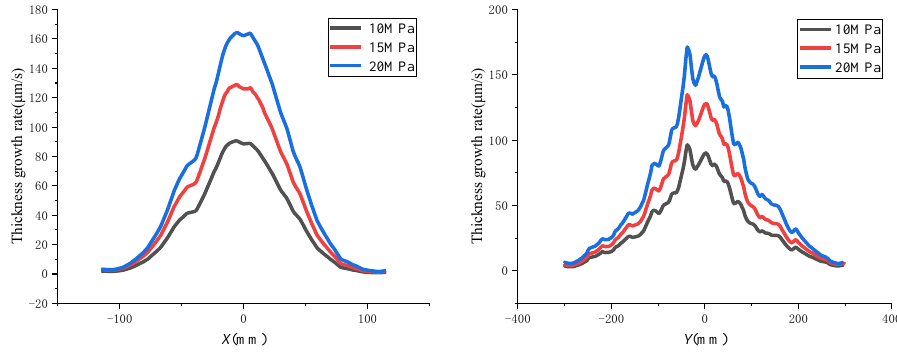
Figure 15. Growth rates of coating films under different spraying pressures.